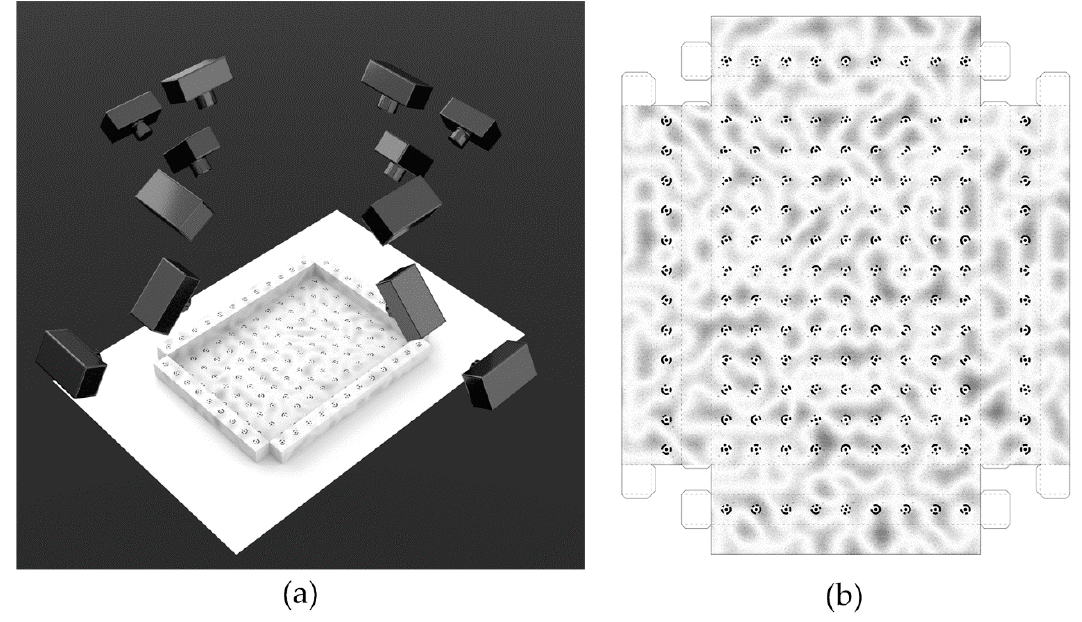
Figure 3. Acquisition set: led light illuminator kit with Relio2 ( a ); white translucent canvas box ( b ). In both figures, the rotating support with coded target cubes radially placed along its thickness is visible.